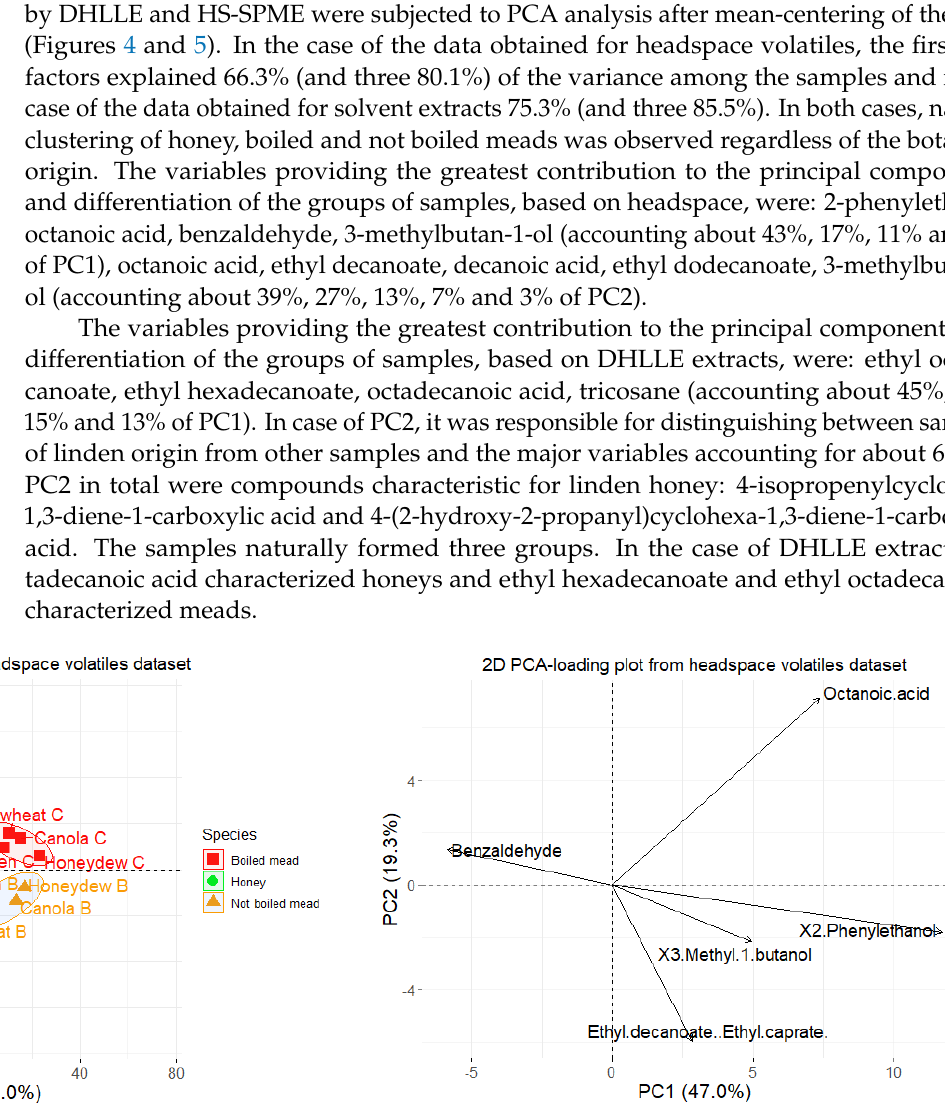
Figure 4. Principal component analysis (PCA) scores ( left ) and loadings ( right , only first five variables with the highest contributions are shown) plots based on the HS-SPME volatiles extract dataset.